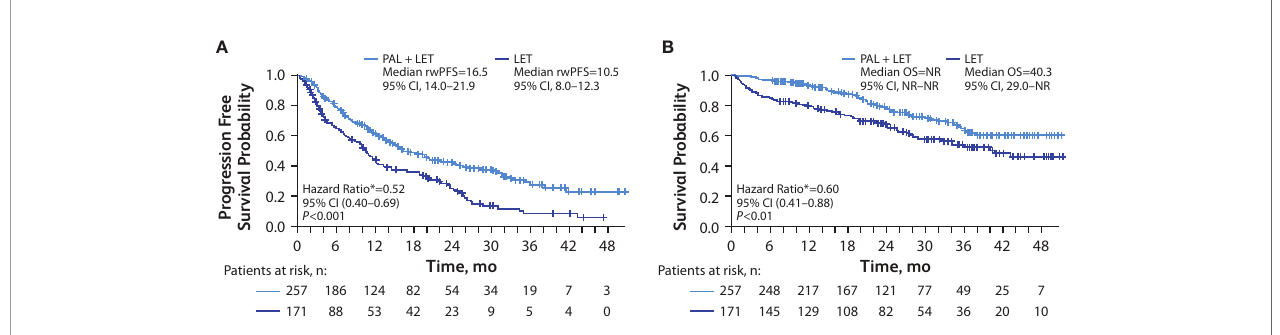
FIGURE 3 | Kaplan-Meier curves of real-world progression-free survival and overall survival in patients with lung metastasis. Analysis of rwPFS (A) and OS (B) adjusted for demographic and clinical variables; number of patients at risk are shown. LET, letrozole; NR, not reached; OS, overall survival; PAL, palbociclib; rwPFS, real-world progression-free survival. *Hazard ratios were estimated by multivariate Cox regression models adjusted for baseline demographic and clinical variables.